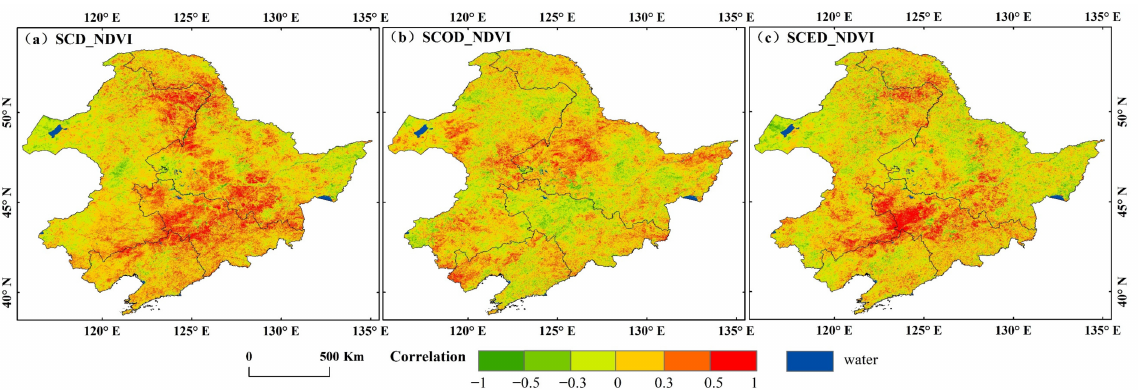
Figure 17. Spatial pattern of correlations between the NDVI and snow phenology. ( a ) SCD, ( b ) SCOD, ( c )